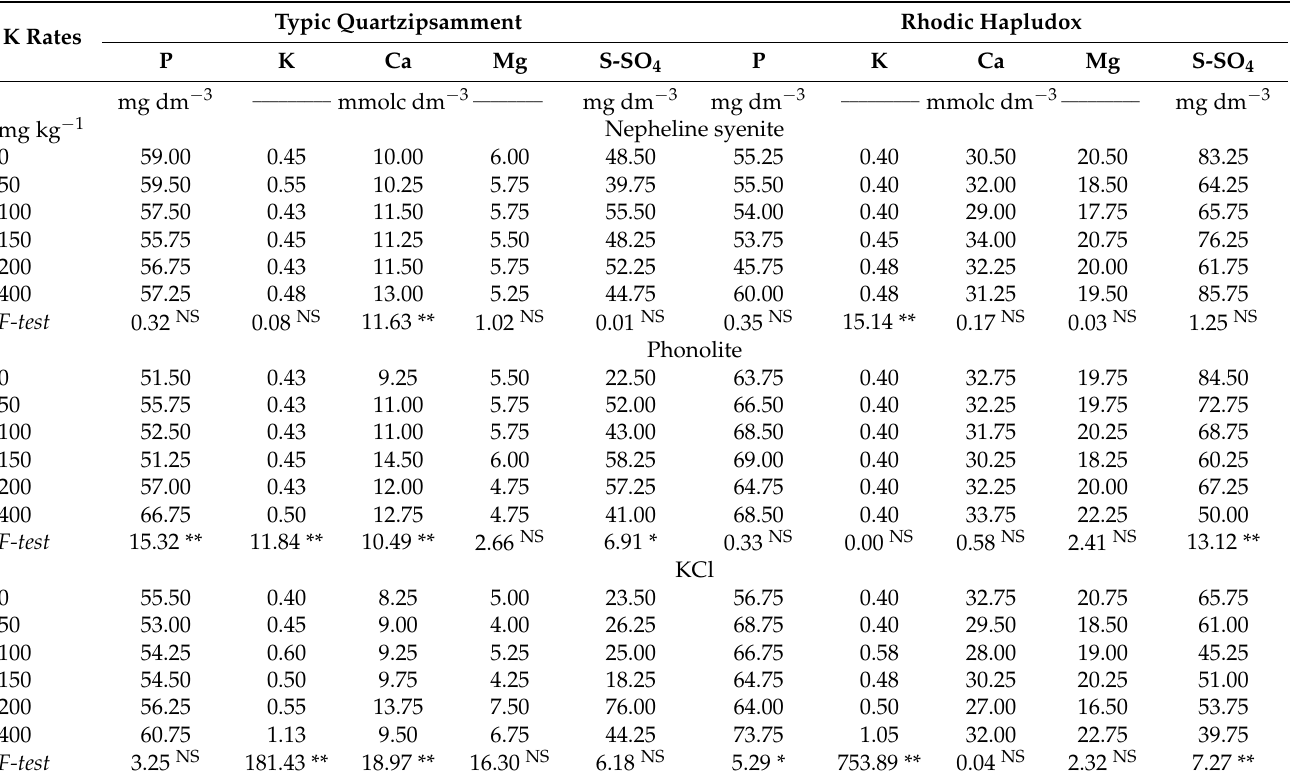
Table 7. Macronutrient concentrations after maize cultivation in the Typic Quartzipsamment, and in the Rhodic Hapludox, depending on the rates and sources of